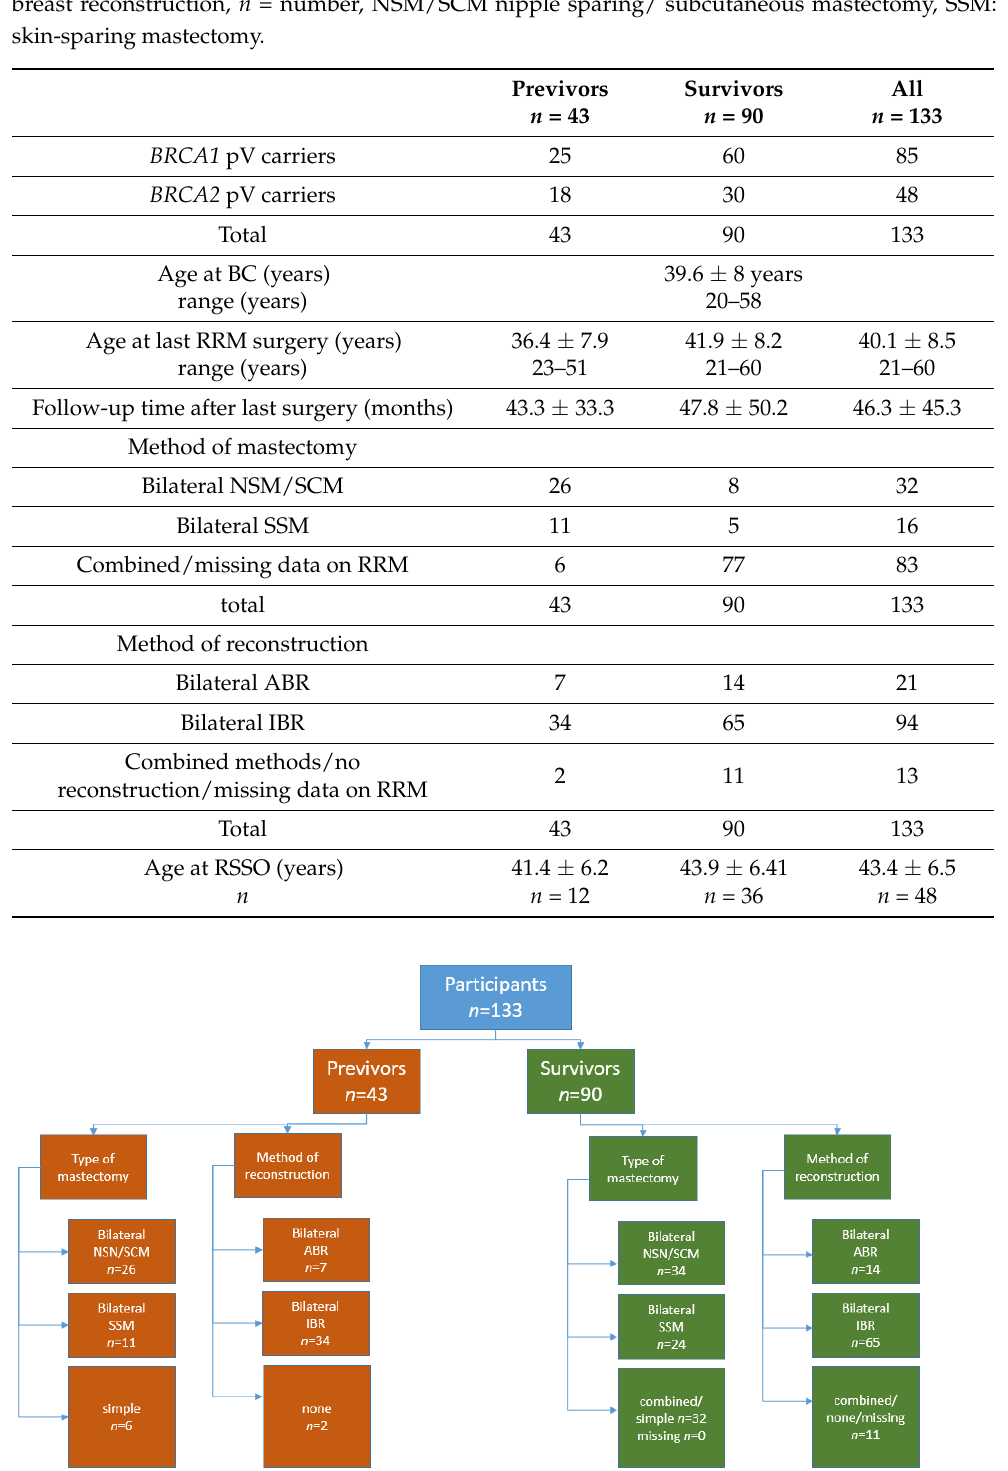
Figure 1. Cohort diagram. Study participants and method of mastectomy and reconstruction. Missing indicates number of missing information on RRM. Legend: ABR: autologous ‐ based breast reconstruction, IBR: implant ‐ based breast reconstruction, n = number, NSM/SCM nipple sparing/ subcutaneous mastectomy, SSM: skin ‐ sparing mastectomy.